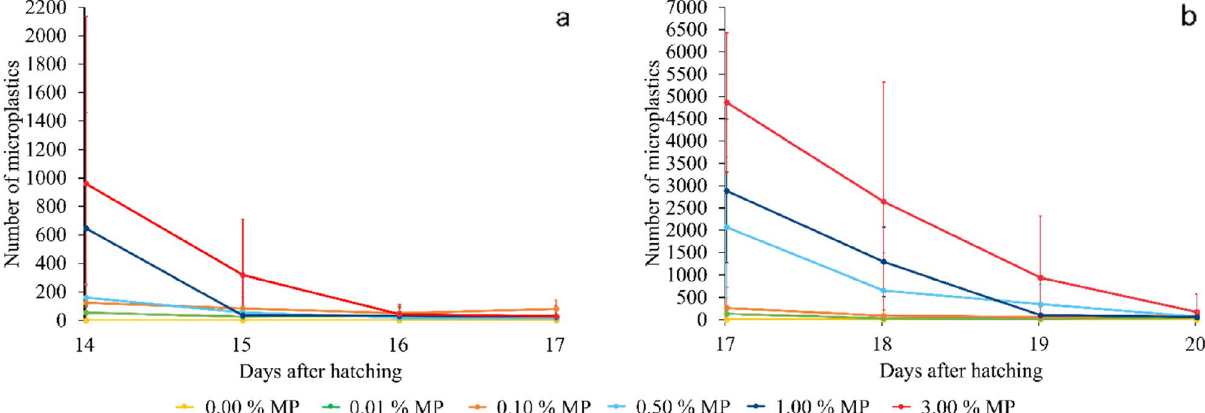
Figure 4. Retention of microplastics (MP) by BSF larvae reared on an artificial food waste stream containing different microplastic contents ( w MP = 0.00, 0.01, 0.10, 0.50, 1.00, 3.00%) of fluorescent blue-labelled polyethylene microplastics. ( a ) Represents the retention of microplastics starting at 14 DAH and ( b ) depicts the retention of microplastics starting at 17 DAH, both by showing the number of retained microplastics in the gut of the BSF larvae. The results shown are the mean values ( n = 9), while the error bars depict standard